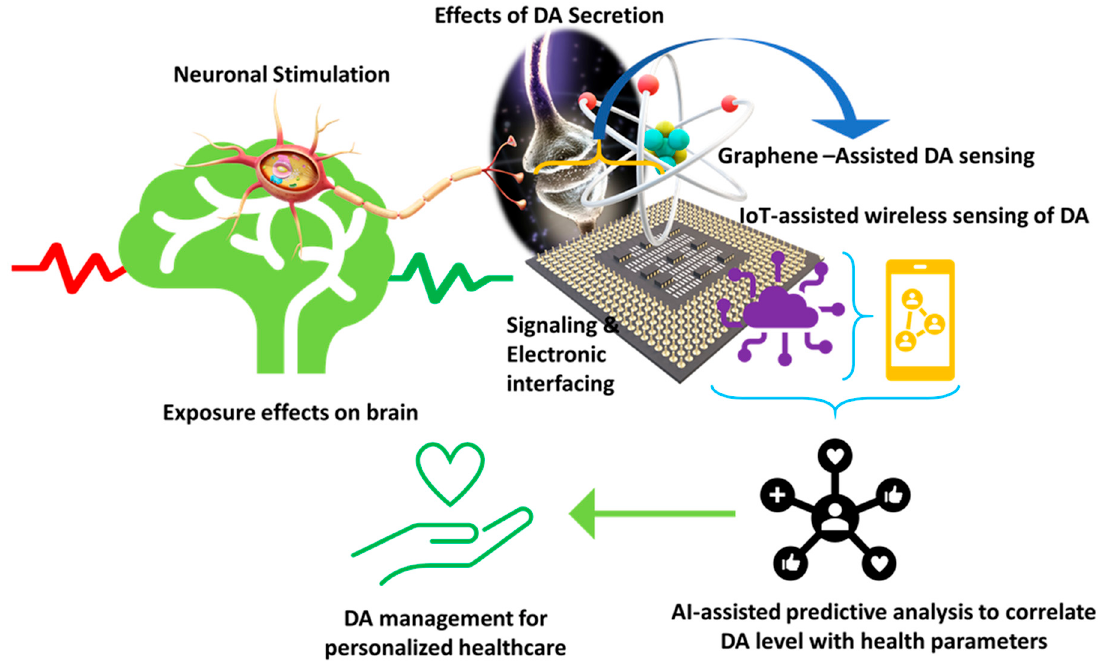
Figure 5. Illustration of a futuristic approach based on sensor-IoT-AI-goal of PD management.